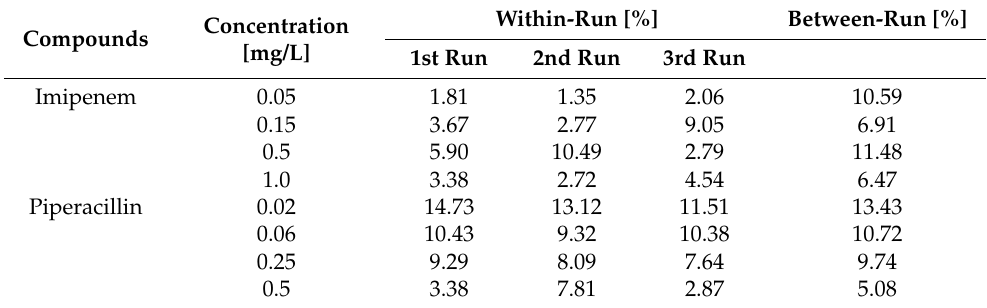
Table 3. Within- and between-run accuracy presented as the percent of nominal concentration of the analyte.